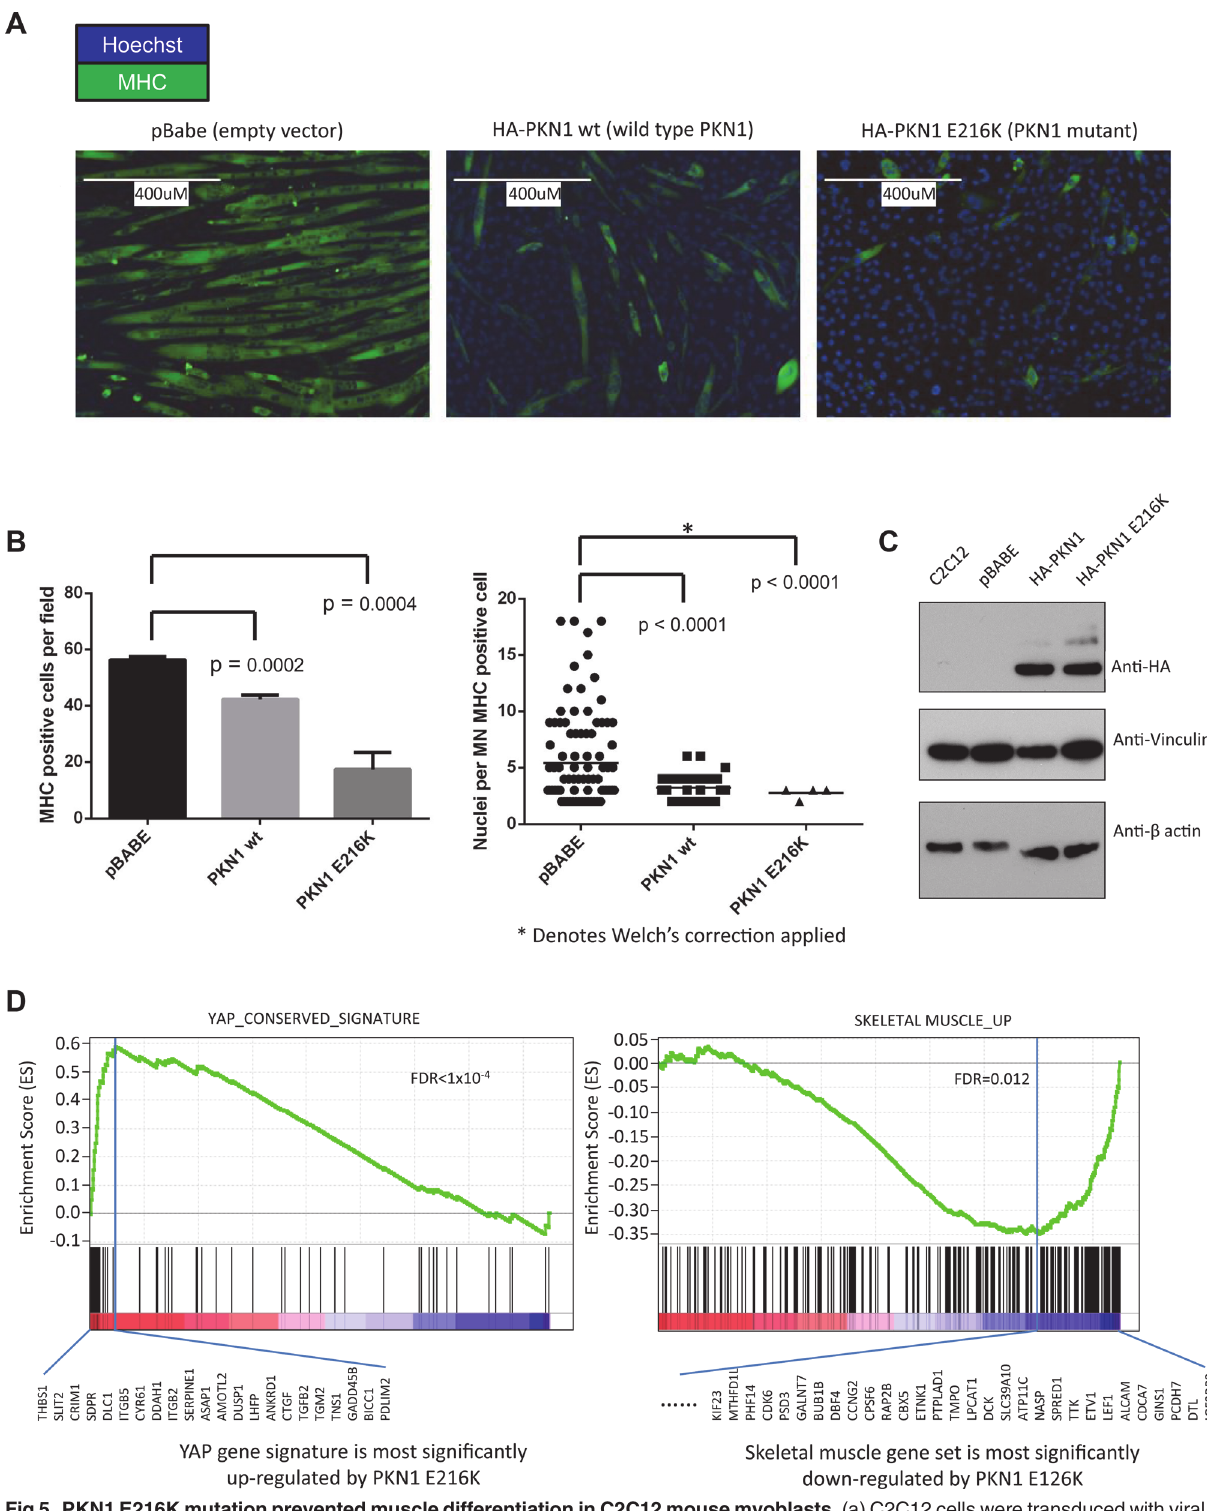
Fig 5. PKN1 E216K mutation prevented muscle differentiation in C2C12 mouse myoblasts. (a) C2C12 cells were transduced with viral constructs containing either empty vector (pBabe), wild type PKN1 (HA-PKN1 wt) or PKN1 E216 mutant (HA-PKN1 E216K). Immunofluorescence performed for myosin heavy chain showed a striking arrest of terminal muscle differentiation. The size bar represents 400um. (b) Quantitation of the observed phenotype showed a significant decrease myosin heavy chain positive cells when PKN1 E216K is expressed. (c) Immunoblot demonstrating expression of HA tagged wild